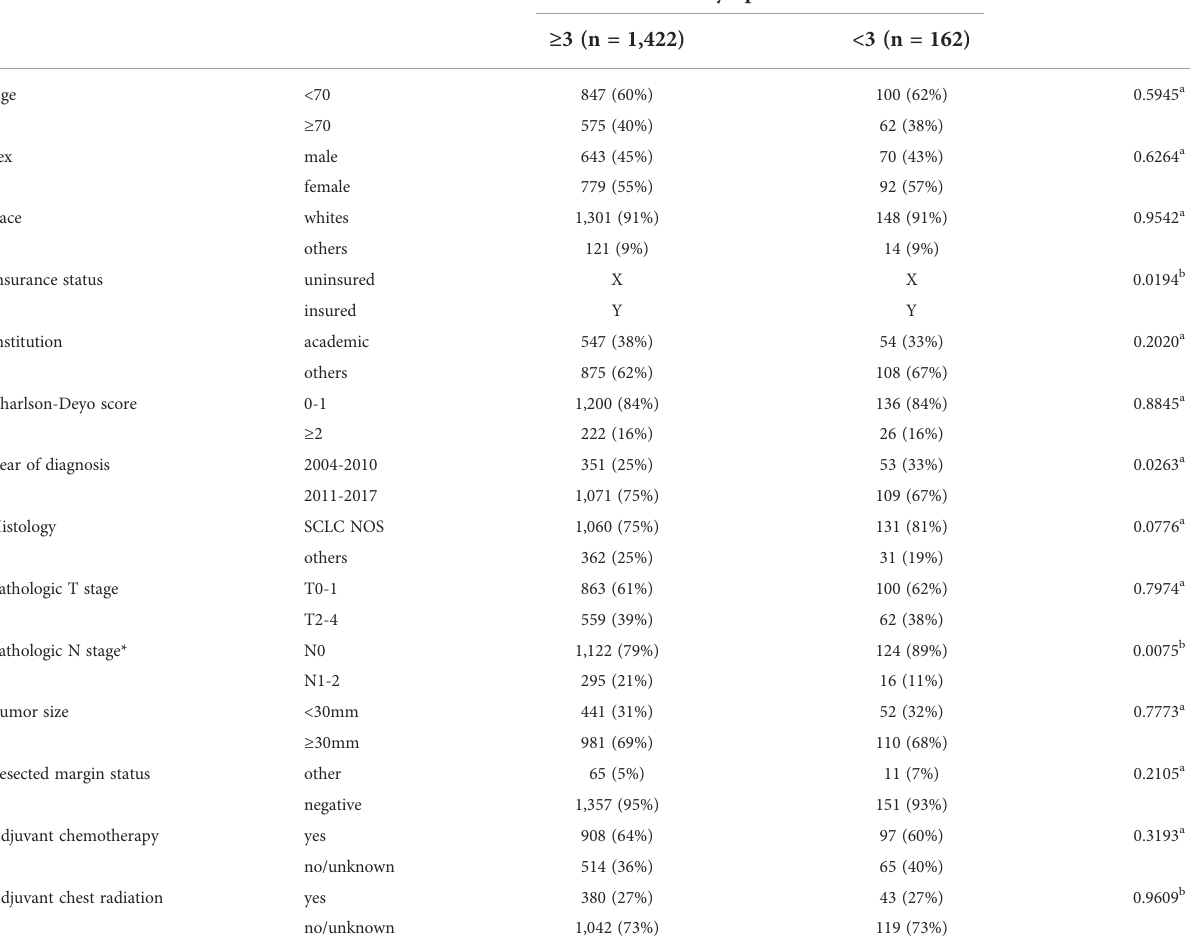
TABLE 2 Patient characteristics of resected clinical stage I-II (AJCCv7) small cell lung cancer according to number of lymph nodes dissected (n =